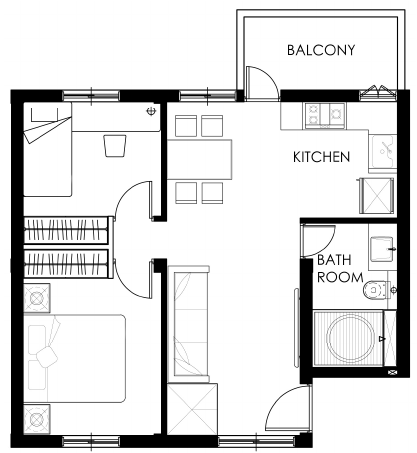
Figure 4. Case floor plan.